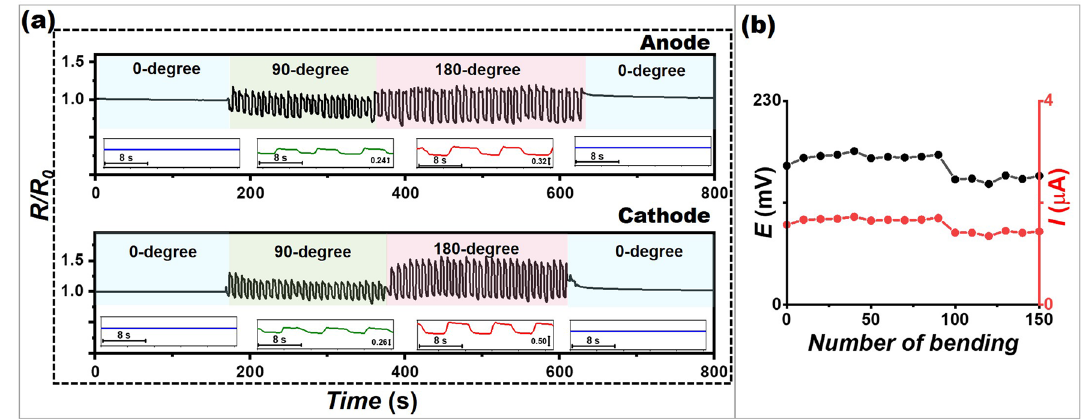
Fig. 6 Electrical and electrochemical endurance of the printed device under multiple deformations. a The repetitive mechanical deformations of a screen-printed anode and cathode on PET material at 0°, 90°, 180°, and 0° bending. b The voltage output and current obtained from a screen- printed glucose BFC with no applied potential in the presence of 5 mM glucose in artificial sweat after a series of deformation at 180° bending. The voltage was observed at a constant load between electrodes of 99.7